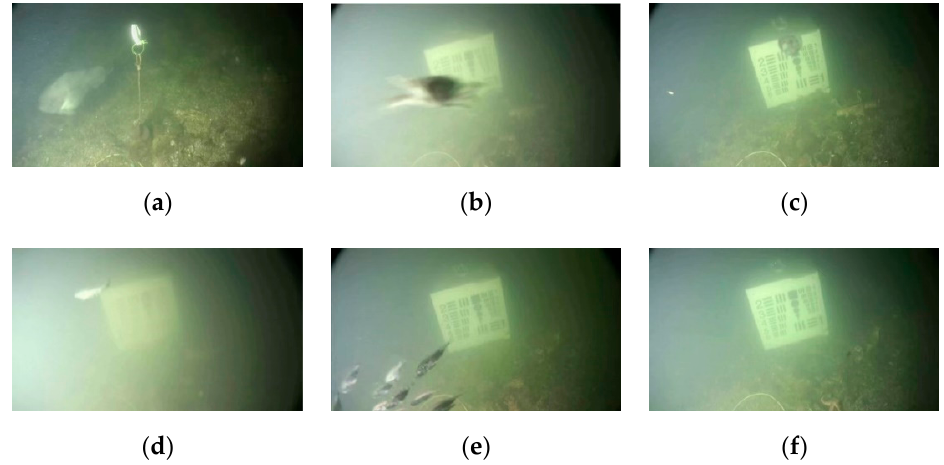
Figure 7. Example of the Brackish dataset. ( a ) Big fish. ( b ) Crab. ( c ) Jellyfish. ( d ) Shrimp. ( e ) Small fish. ( f ) Star fish.